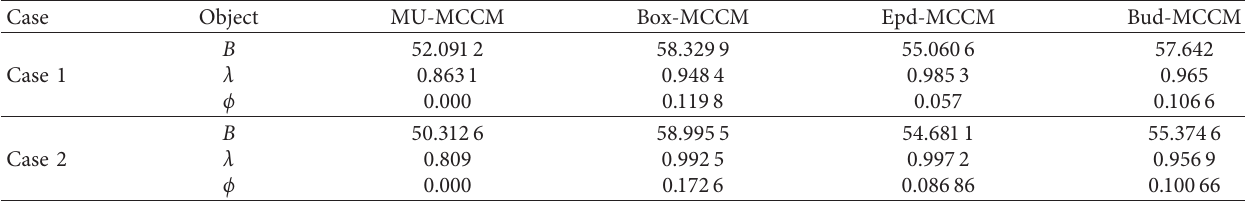
Table 8: Minimum cost consensus models with utility preferences and their conservative